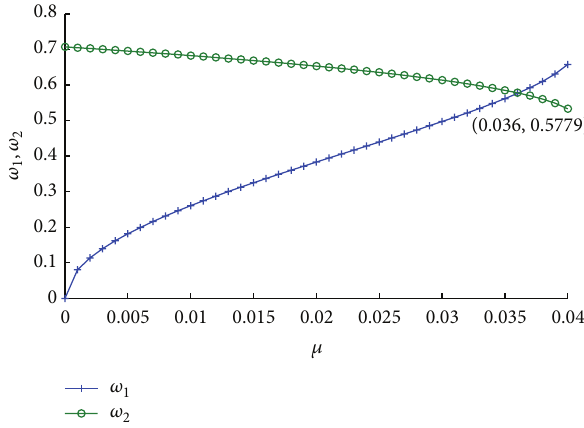
Figure 5: Correlation between 𝜇 and 𝜔 1 and 𝜔 2 with 𝛽 1 = 0.01 , = 0.02 , 𝐴 = 0.001 , and 𝐴 𝛽 2 1